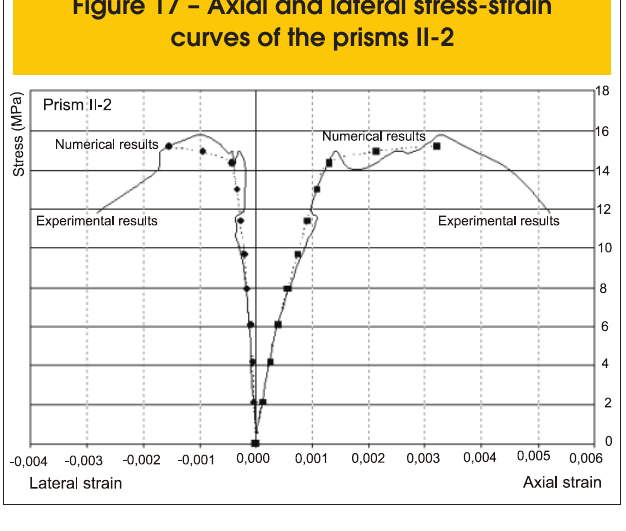
Figure 17 – Axial and lateral stress-strain curves of the prisms II-2